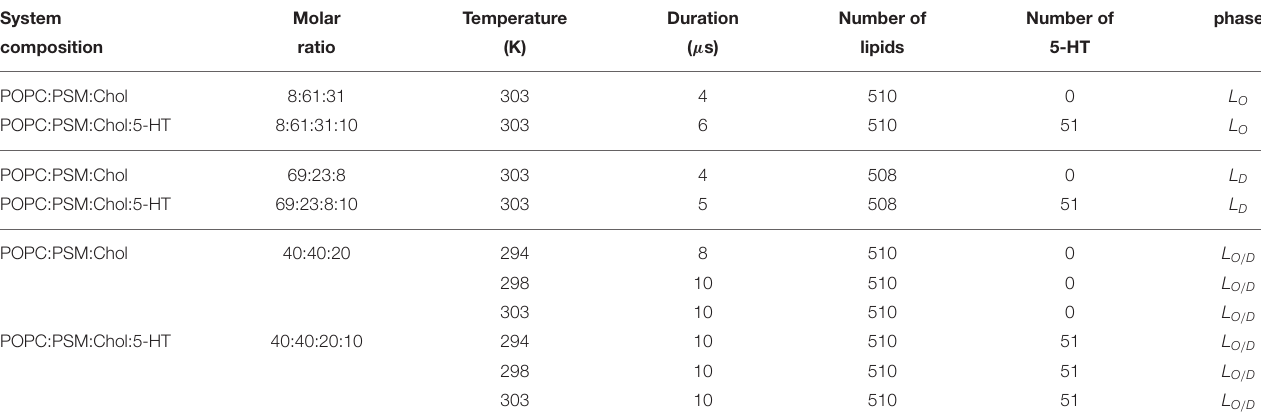
TABLE 1 | Simulated systems. System Molar Temperature Duration Number of Number of phase